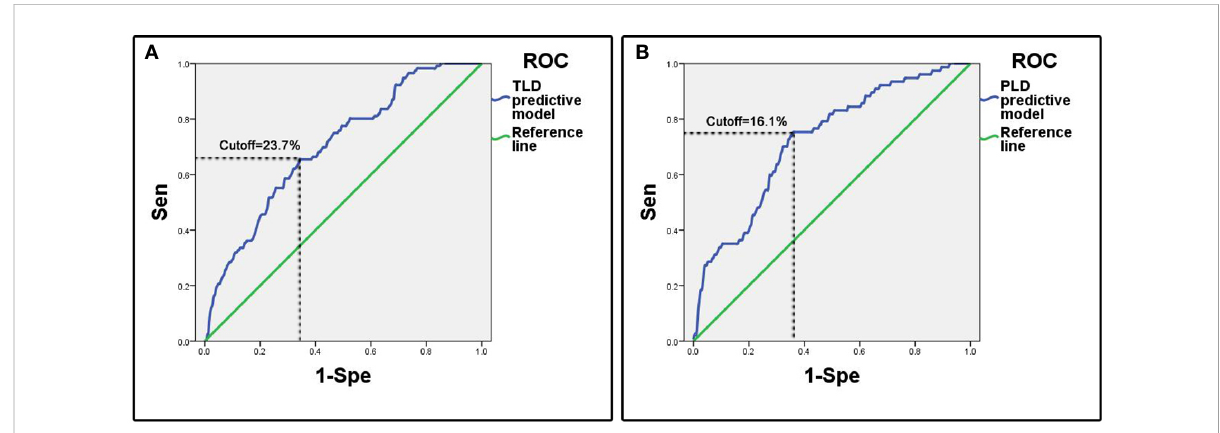
FIGURE 1 ROC curves of predictive models. (A) Predictive model of temporary language de fi cit, the cutoff value of predictive probability of TLD was 23.7%, the Sen was 0.66 and the Spe was 0.66. (B) Predictive model of permanent language de fi cit, the cutoff value of predictive probability of PLD was 16.1%, the Sen was 0.75 and the Spe was